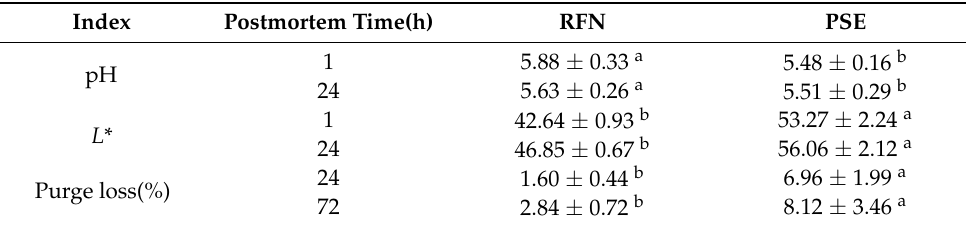
(Table 1). The pH of the PSE meat was significantly lower than that of the RFN meat group at 1 h and 24 h postmortem ( p < 0.05). Purge loss is an important indicator of pork WHC. The purge loss of PSE meat at 24 h and 72 h postmortem increased significantly—by more than 5%—compared to the RFN meat ( p < 0.05). The L* of the PSE meat was significantly higher than that of RFN meat at 1 h and 24 h postmortem. Table 1. The pH, lightness ( L* ) and purge loss of red, firm and non-exudative (RFN), and pale, soft and exudative (PSE) meat during postmortem aging.